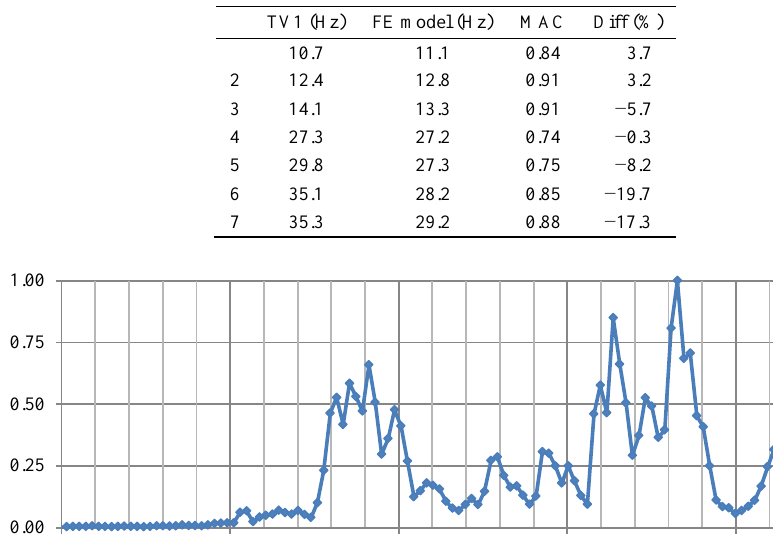
Comparison of natural frequencies from Floor Level 1 for TV1 and the 3D FE model